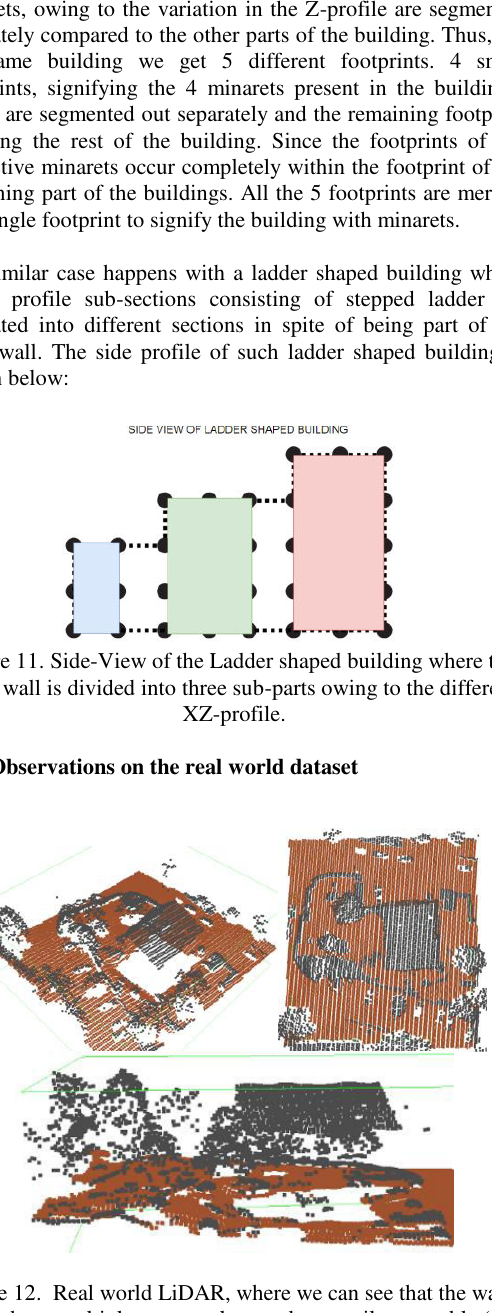
Figure 12. Real world LiDAR, where we can see that the walls don't have multiple return values and not easily separable (a) Perspective view (b) Top view (c) Side